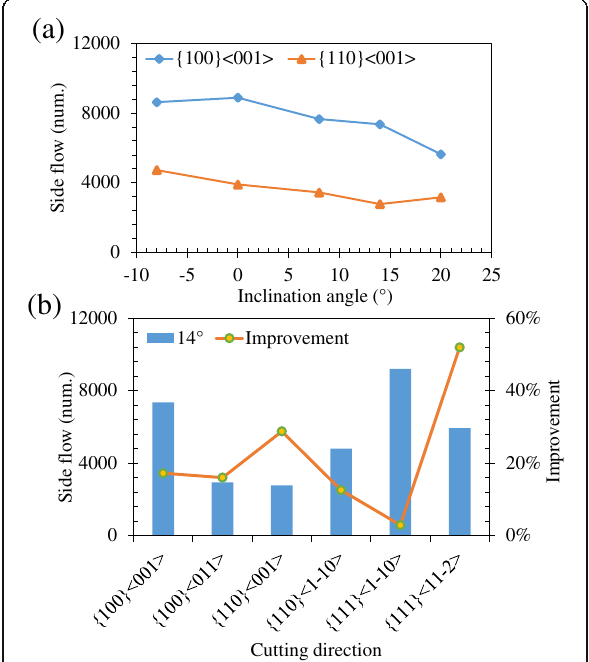
Fig. 15 Number of atoms flow to the side of tool edge with different ( a ) inclination angles and ( b ) cutting